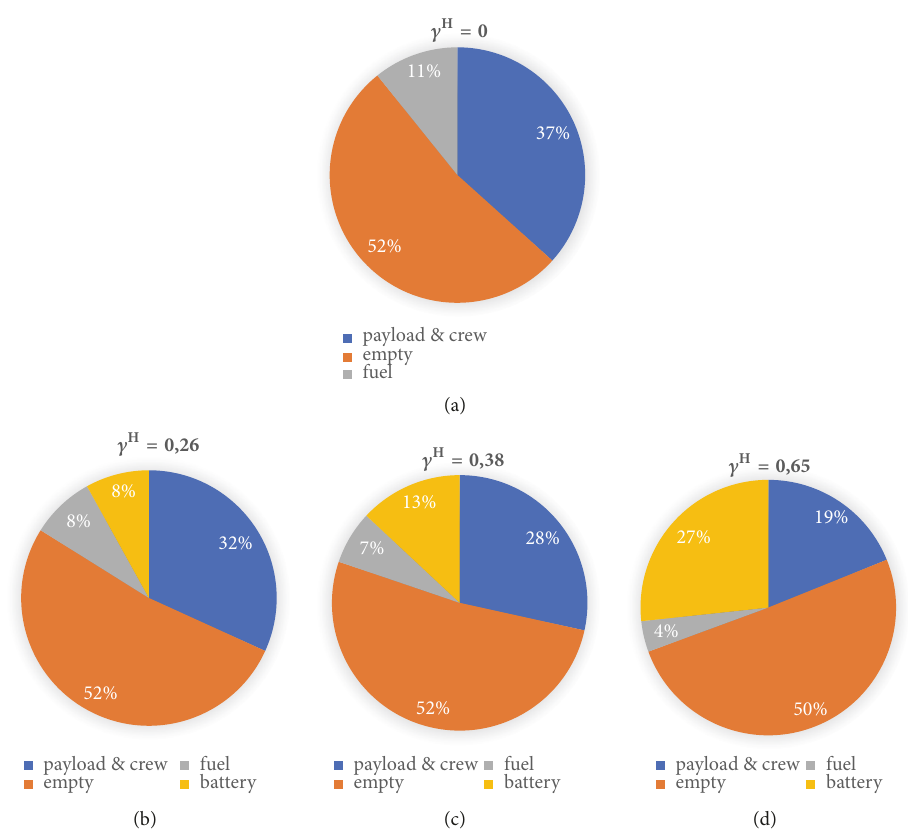
Figure 11: Regional high-capacity BWB aircraft MTOM breakdown for 𝛾 𝐻 = 0 (a), 𝛾 𝐻 = 0.26 (b), 𝛾 𝐻 = 0.38 (c), and 𝛾 𝐻 = 0.65